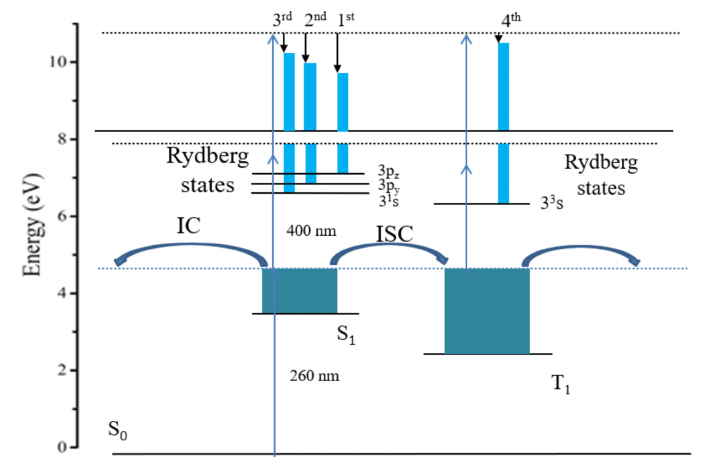
Figure 7. Schematic representation of the excitation and ionization scheme of 2-methlypyrazine using 260 nm pump and 400 nm probe